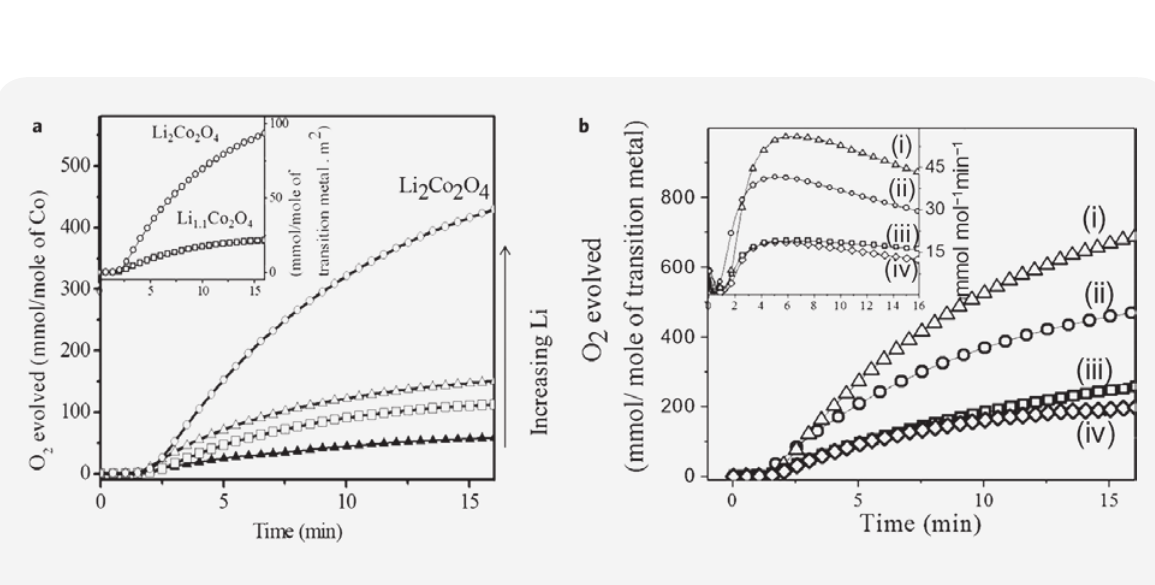
Figure 10. (a) Comparison of amount of O 2 evolved by Li x Co 2 O 4 with different amount of Li. (  ) Li 2 Co 2 O 4 and (  ) Li 1.1 Co 2 O 4 . (b) Comparison of amount of O 2 evolved in (i) LaCoO 3 , (ii) Li 2 Co 2 O 4 , (iii) Mn 2 O 3 , and (iv) LaMnO 3 . Reproduced with permission from Ref. 25.